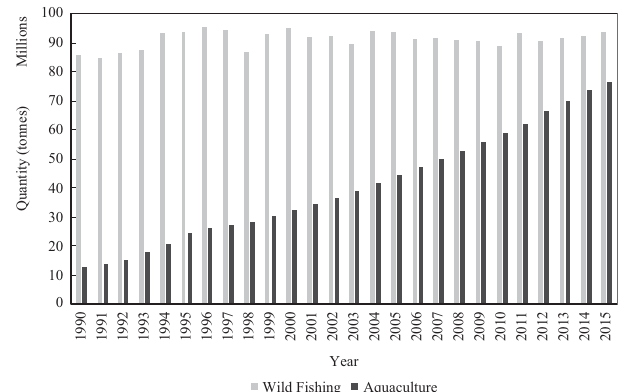
Figure 1. Comparison of global production from wild fishing and